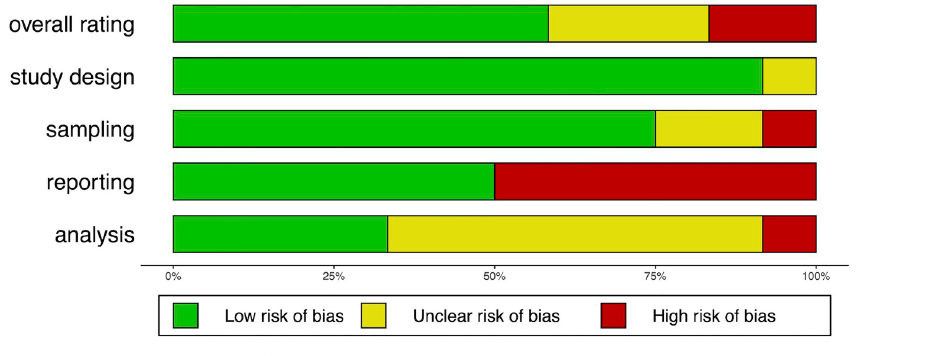
Fig 3. RoB assessment across all water